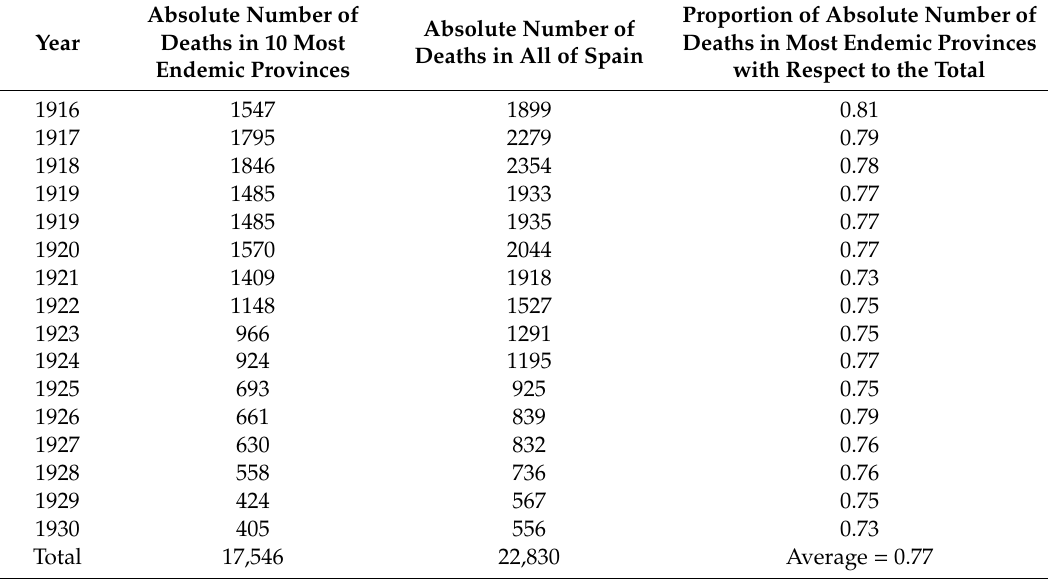
Table 1. Concentration of deaths by autochthonous malaria in 10 Spanish provinces with higher mortality in the period